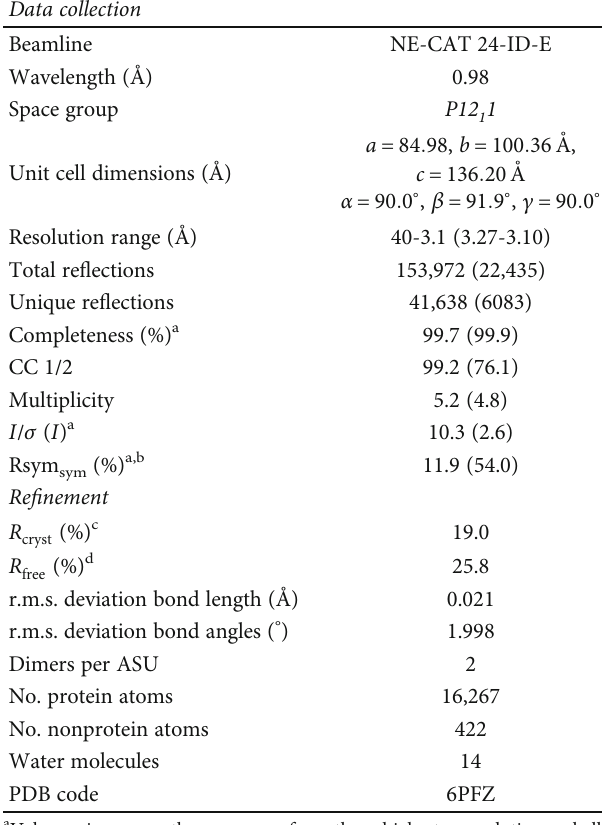
Table 1: X-ray data collection and re fi nement statistics for Af